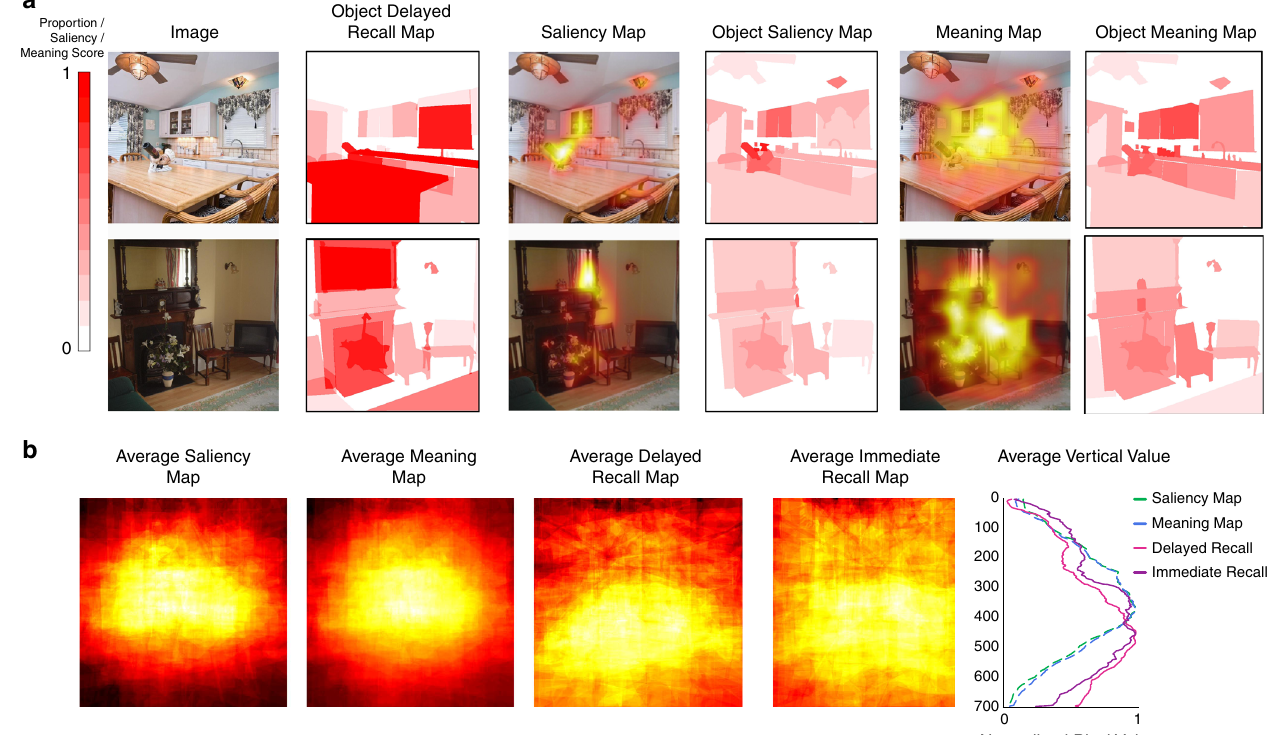
Fig. 5 Comparing image-based metrics with object memory. a A comparison of which objects participants drew during Delayed Recall and the objects predicted by a graph-based visual saliency map (GBVS 40 ) and Meaning Maps 41,42 . The Object Memory Map shows the proportion of participants who drew each object during Delayed Recall; red indicates objects drawn by all participants who remembered a given drawing, whereas white indicates objects drawn by no one, as well as background regions. The Saliency Map shows the saliency scores calculated for each pixel based on the GBVS algorithm, while the Meaning Map shows the average smoothed meaning scores attributed to circular patches taken from each image (see 41 ). Their corresponding Object Maps show the average saliency and meaning scores across all pixels within a given object region, scaled to a range of 0 to 1. All results reported replicate when Object Maps are instead generated using peak saliency and meaning within an object. b The average maps across all experimental images, averaging (in order) the Object Saliency Maps, Object Meaning Maps, Object Delayed Recall Memory Maps, and Object Immediate Recall Memory Maps. Maps were normalized by number of objects across images at each pixel to take into account the natural spatial distribution of objects. The average vertical value shows the mean pixel value at each y -coordinate (from top pixel 0 to bottom pixel 700) for the four average maps, scaled to a range of 0 to 1. As one can see, while Saliency and Meaning Maps show a central bias, Delayed and Immediate Recall Maps show a tendency towards the lower part of the